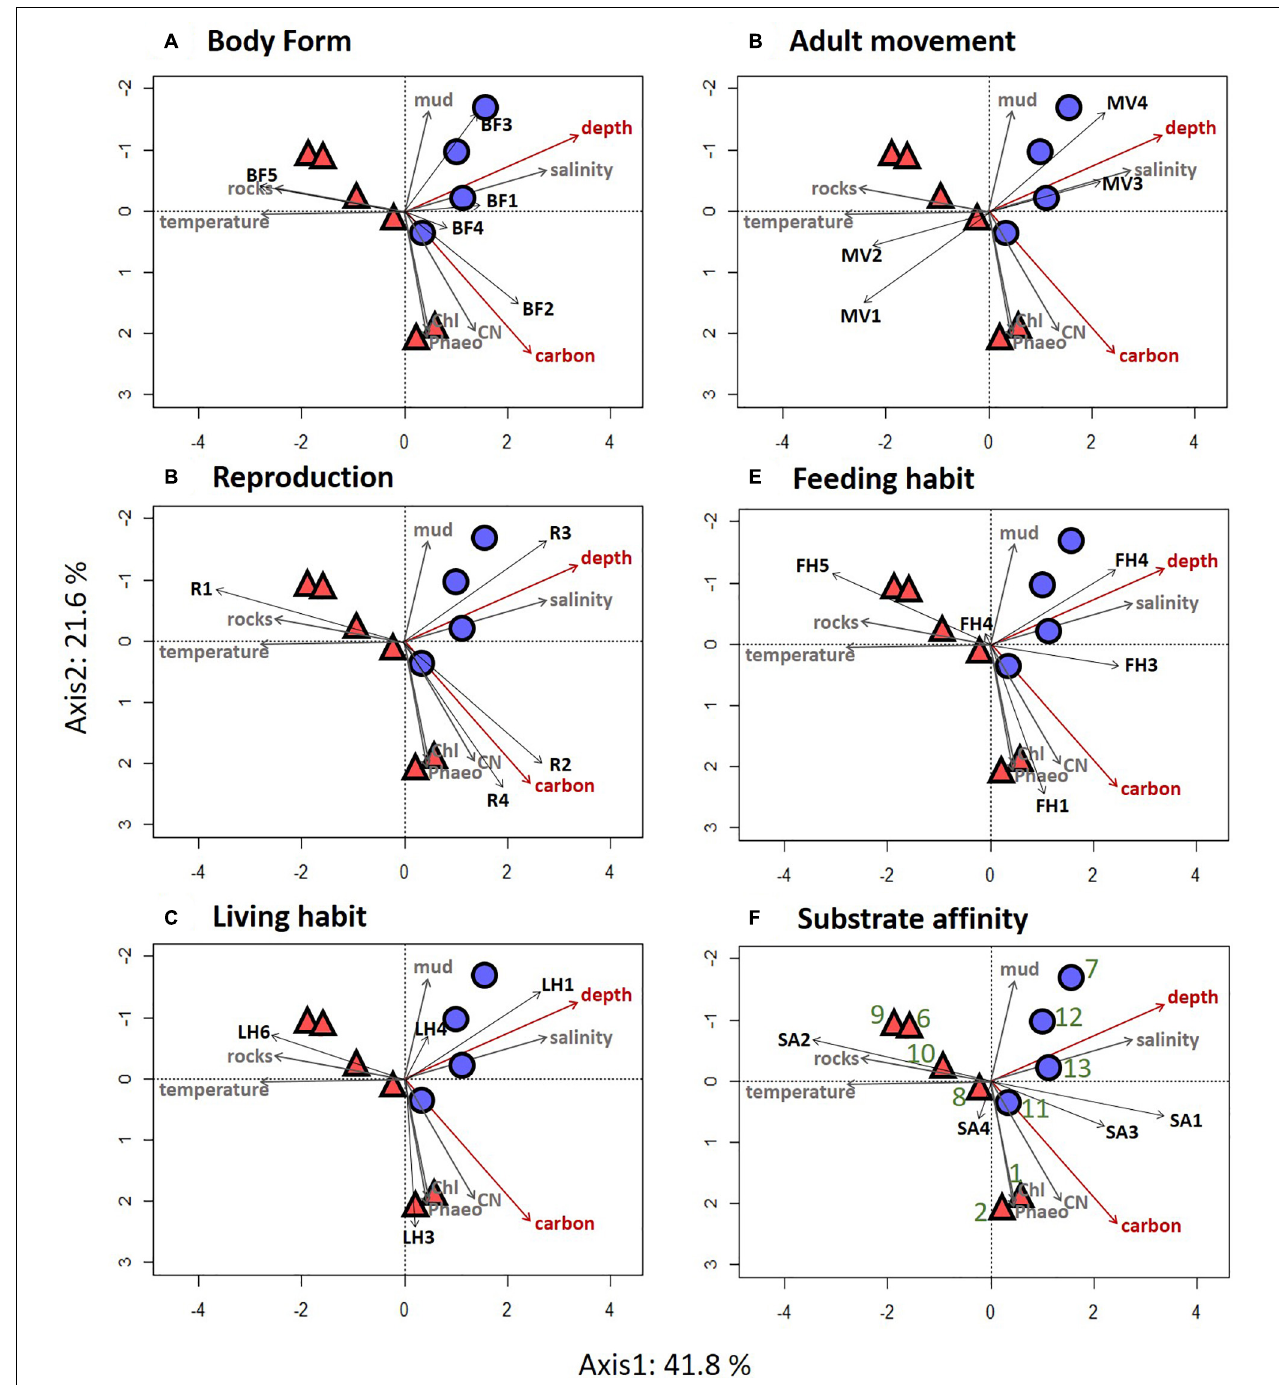
FIGURE 6 | Results of the canonical correspondence analysis (CCA) performed on the traits by stations matrix for ROV data of the epifauna from the Chukchi Borderland. Traits identified as most important in the Fuzzy Correspondence Analysis are presented; (A) body form, (B) reproduction, (C) living habit, (D) adult movement, (E) feeding habit, and (F) substrate affinity. Passive environmental factors are overlain on the figure panels in gray color; environmental factors in red are those that were used to constrain the CCA. Mid-depth stations are present in red triangles and deep stations are present in blue circles. Station numbers are identified in green on the last CCA plot. Trait modality codes are abbreviated by two letter-one number combinations and explained in Table 2 .